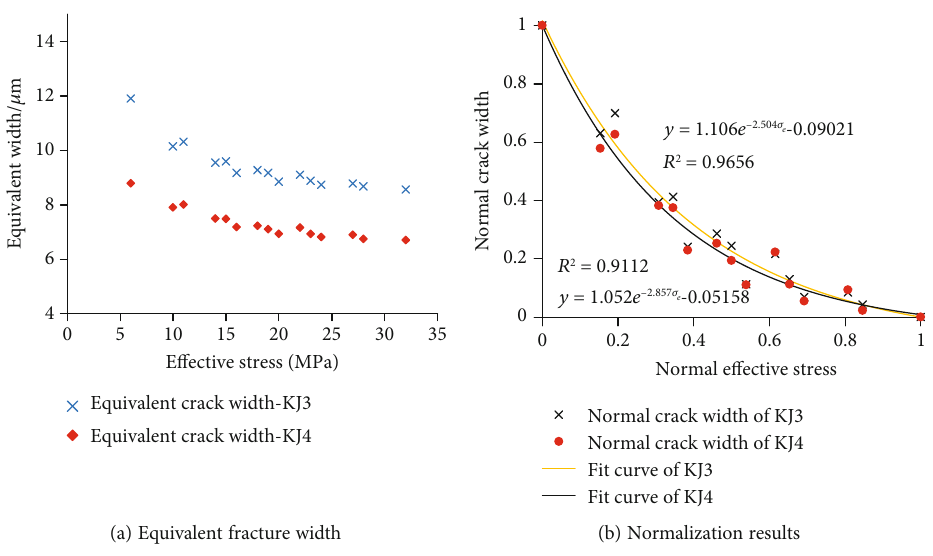
Figure 12: Relationship between equivalent width of fracture and e ff ective